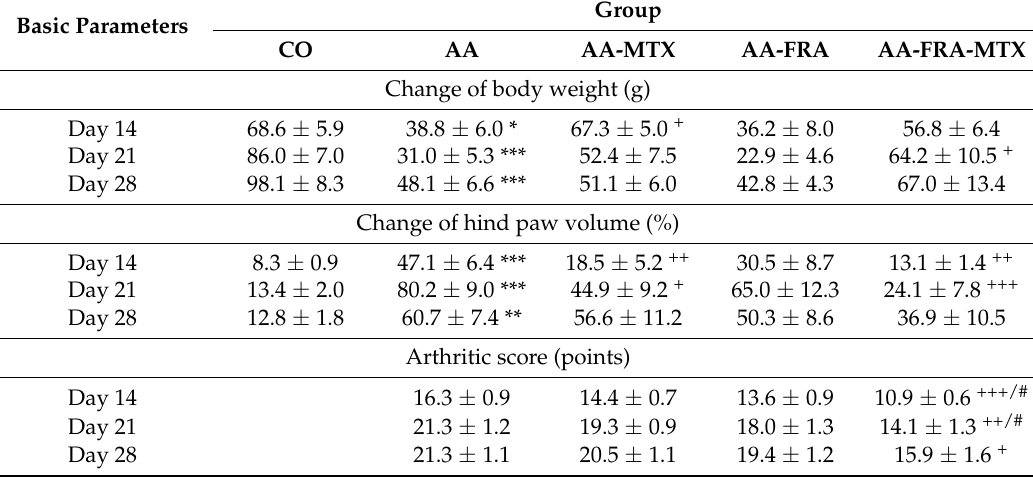
Table 1. Effect of FRA and MTX administered alone or in combination on basic parameters (change of body weight, change of hind paw volume, and arthritic score) in AA on the experimental days 14, 21 and